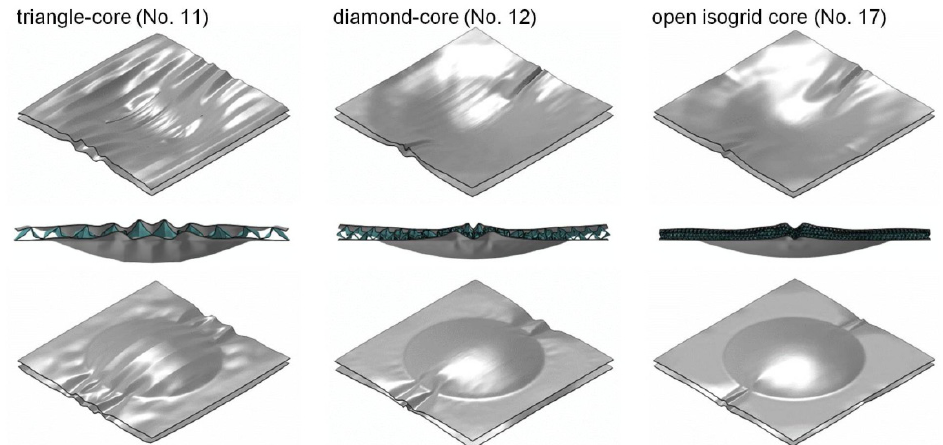
Figure A4. Deformation states of the top and bottom sides for prismatic, one-layered, non-auxetic cores No. 11, 12, and 17 subjected to air-blast loading (t = 0.6 ms).